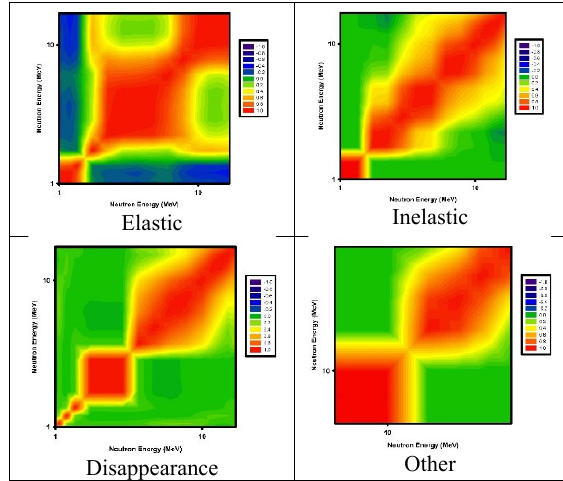
Fig. 6. Correlation matrices in the 28 Si displacement kerma for various classes of reactions